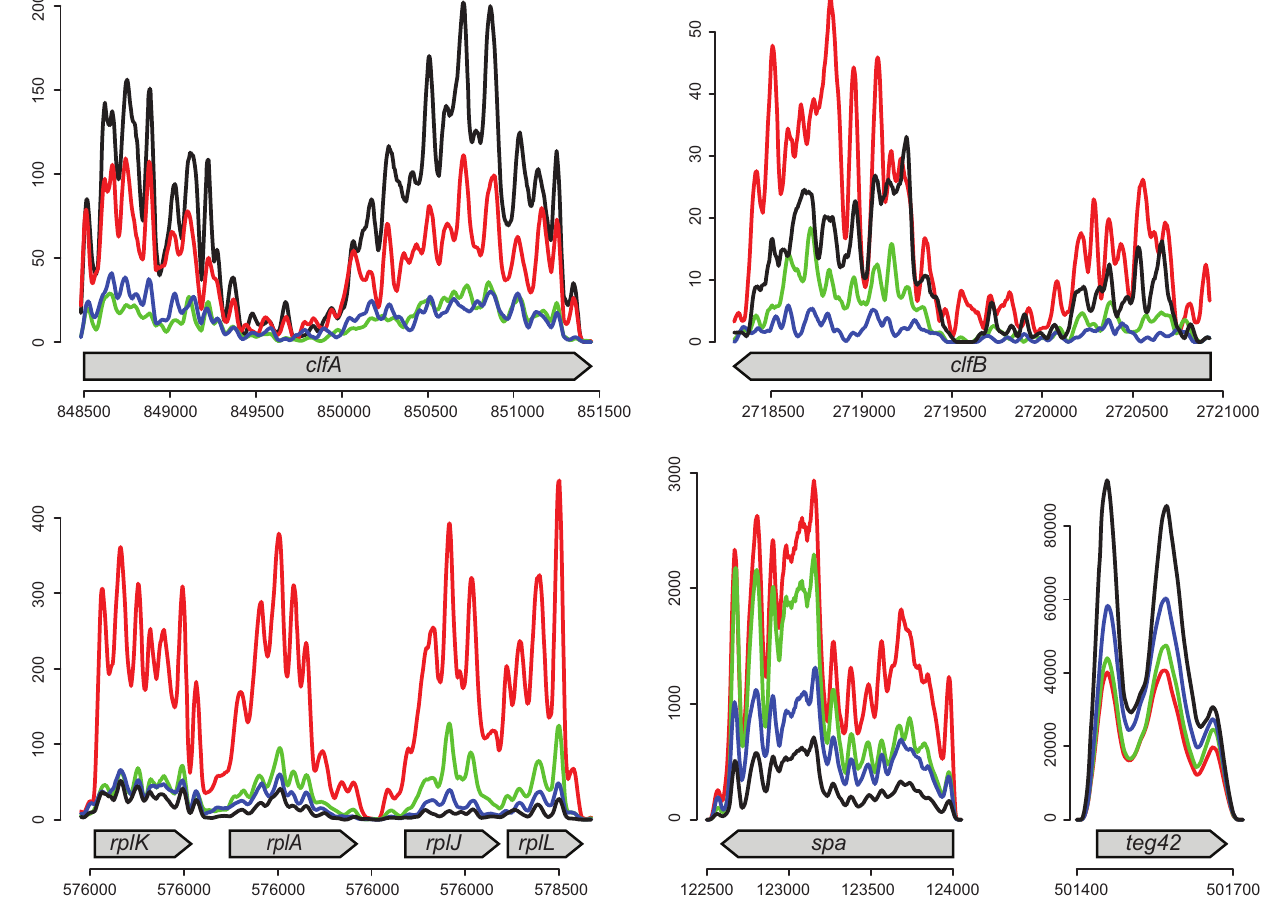
Figure 4. Temporal expression of selected RNAs obtained by RNA-Seq Illumina-HTS. Transcript expression levels are shown at 2 hours (red), 4h (green), 6h (blue), and 8h (black). The X-axis corresponds to N315 genomic coordinate and Y-axis symbolizes the normalized coverage. We smoothed the coverage profiles by using a sliding average window of size 41. The expression profile of control genes has been used for experimental validation. General profiles are consistent with published studies with respect to the temporal expression of these transcripts. The experiment shows that the expression of most small transcripts identified in this study are regulated during the growth phase.